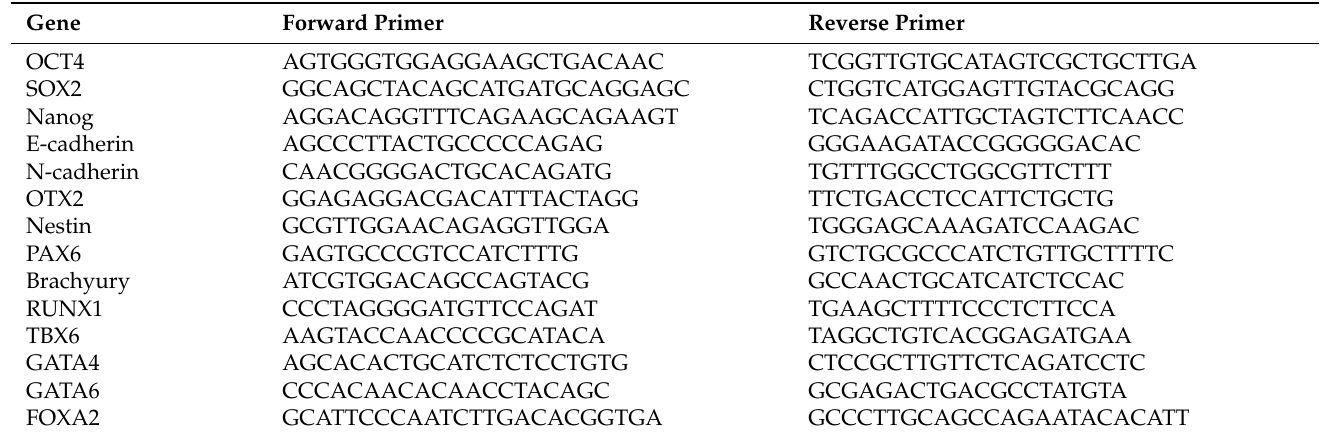
Table 1. Primer sequences used for qRT-PCR